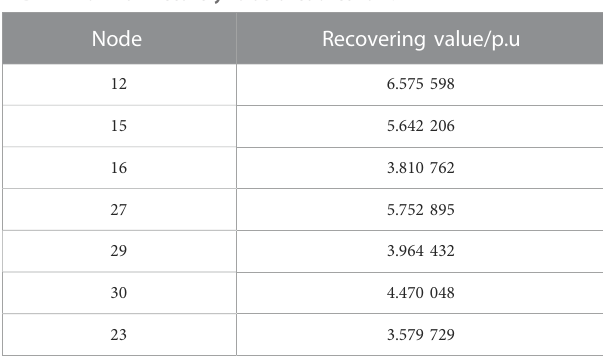
TABLE 7 Maximum recovery value of subnetwork.